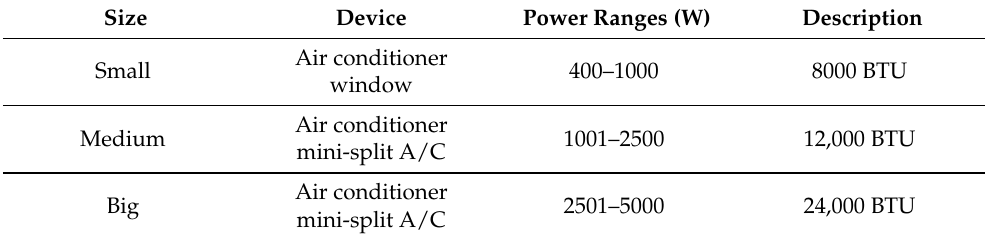
Table 4. Example of power values for an Air conditioner.